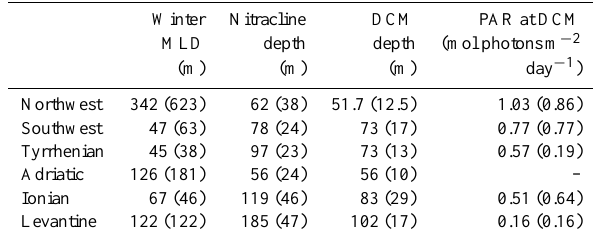
Table 4. Regional average values and standard deviations (numbers in brackets) for a set of parameters. The winter MLD was computed with January and February MLDs. The DCM depth and the PAR (photosynthetically active radiation) at DCM has been computed only for profiles belonging to the DCM standard shape